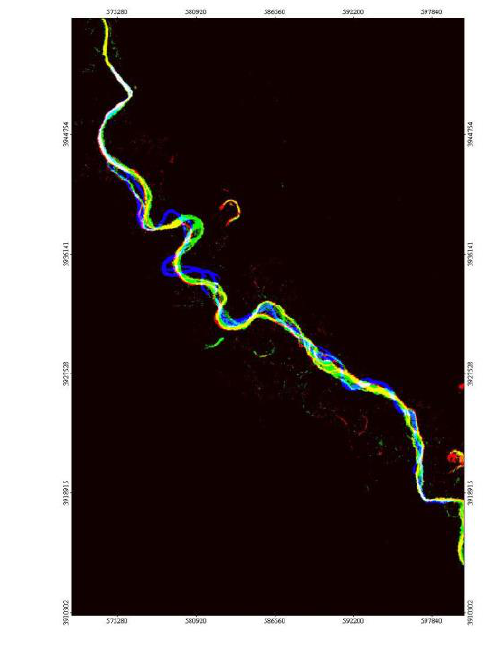
Figure 7. Euphrates channel changes mapped from various satellite images by M. Törmä 2007